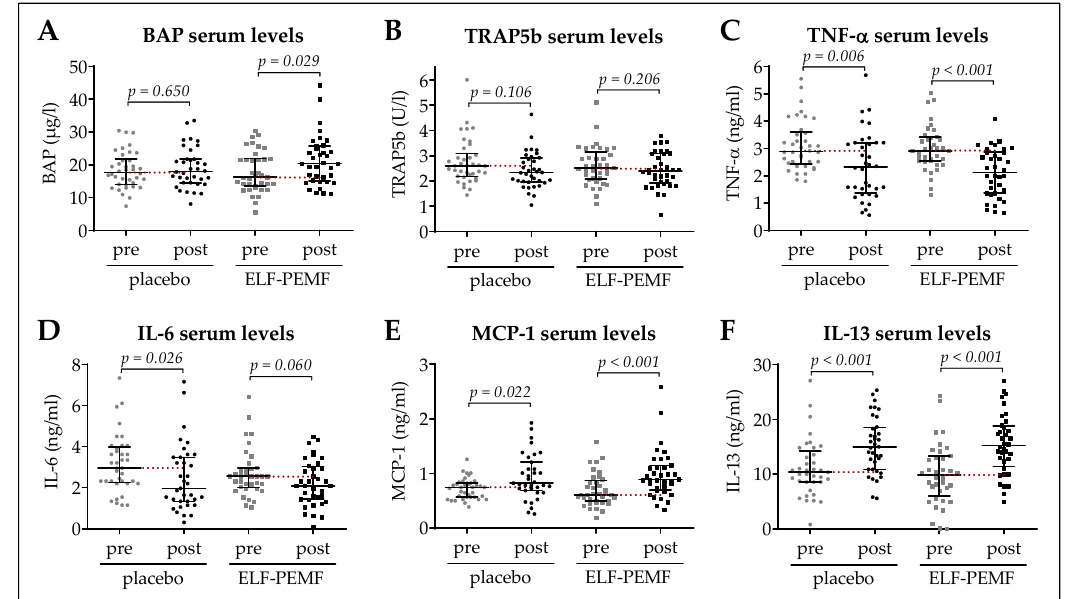
Figure 4. Pre- and post-surgical serum analysis. Serum levels of ( A ) bone-specific alkaline phosphatase (BAP), ( B ) tartrate-resistant acidic phosphatase (TRAP5b), ( C ) tumor necrosis factor alpha (TNF-α), ( D ) interleukin 6 (IL-6), ( E ) monocyte chemoattractant protein 1 (MCP-1), and ( F ) interleukin 13 (IL-13). Data are represented as scatter diagrams (mean ± 95% CI). Placebo: N = 36 and ELF-PEMF: N = 37 ( n = 2). Two-tailed Mann–Whitney U -test was used to determine p -values, as indicated.